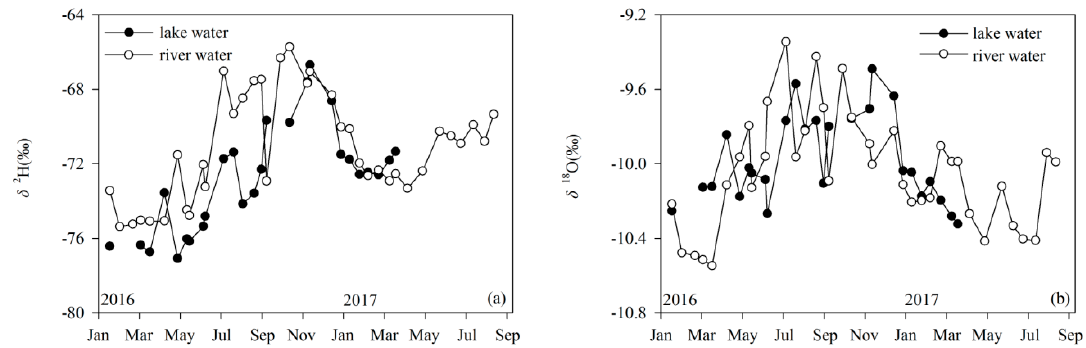
Figure 2. Seasonal variations of δ 2 H and δ 18 O in ( a ) the lake water and ( b ) the river water from 2016 to 2017.